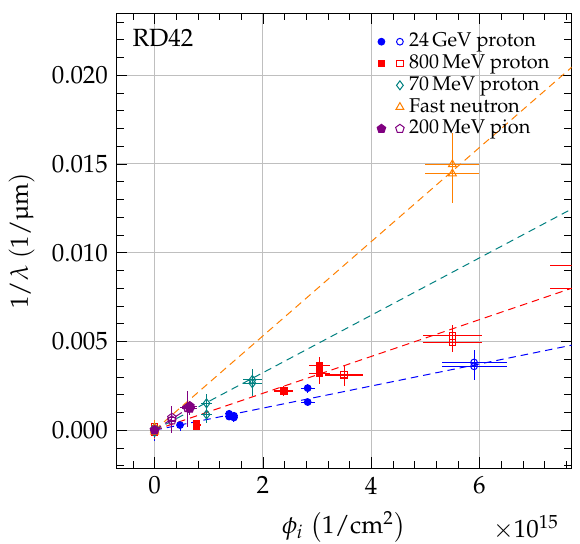
Figure 9. The 1/ λ for scCVD (solid markers) and pCVD (open markers) diamond up to a fluence of 7 10 15 /cm 2 (zoom of dotted box in Figure 8). As reference, the 800MeV proton and 24GeV proton × data from [4] are plotted. Each point is shifted by 1/ λ 0, j .